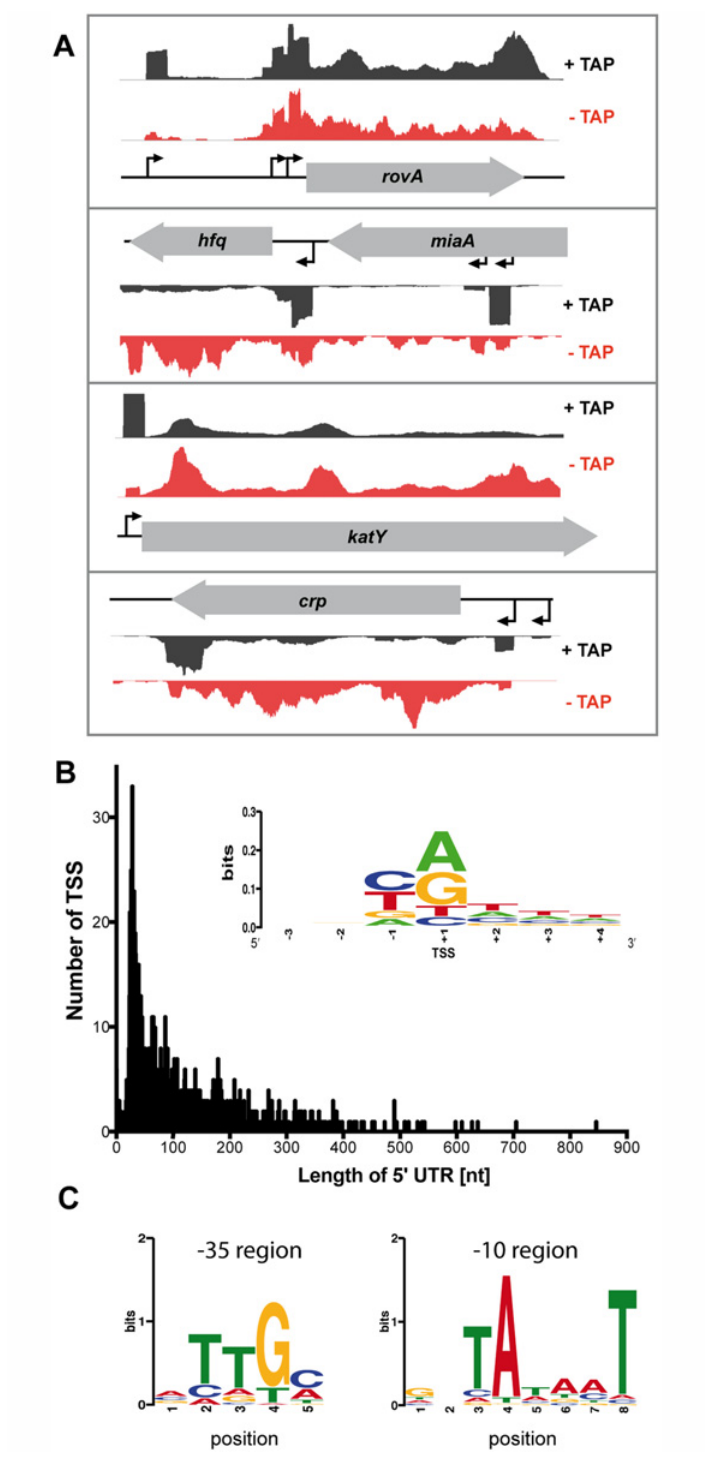
Fig 2. Global identification of mRNA transcriptional start sites (TSSs). (A) Visualization of RNA-seq (+/- TAP) based cDNA sequencing reads mapped to the YPIII rovA , hfq , katY and crp gene locus using the Artemis genome browser (Release 15.0.0). (B) The 5 ’ -UTR repertoire. The distribution and frequency of the length of 5 ’ -UTRs is given for all mRNAs of YPIII which start upstream of the annotated translational start site. More than 40% of all 5 ’ -UTRs are 20 – 60 nt in length. (Inset) Sequence conservation at the TSSs.